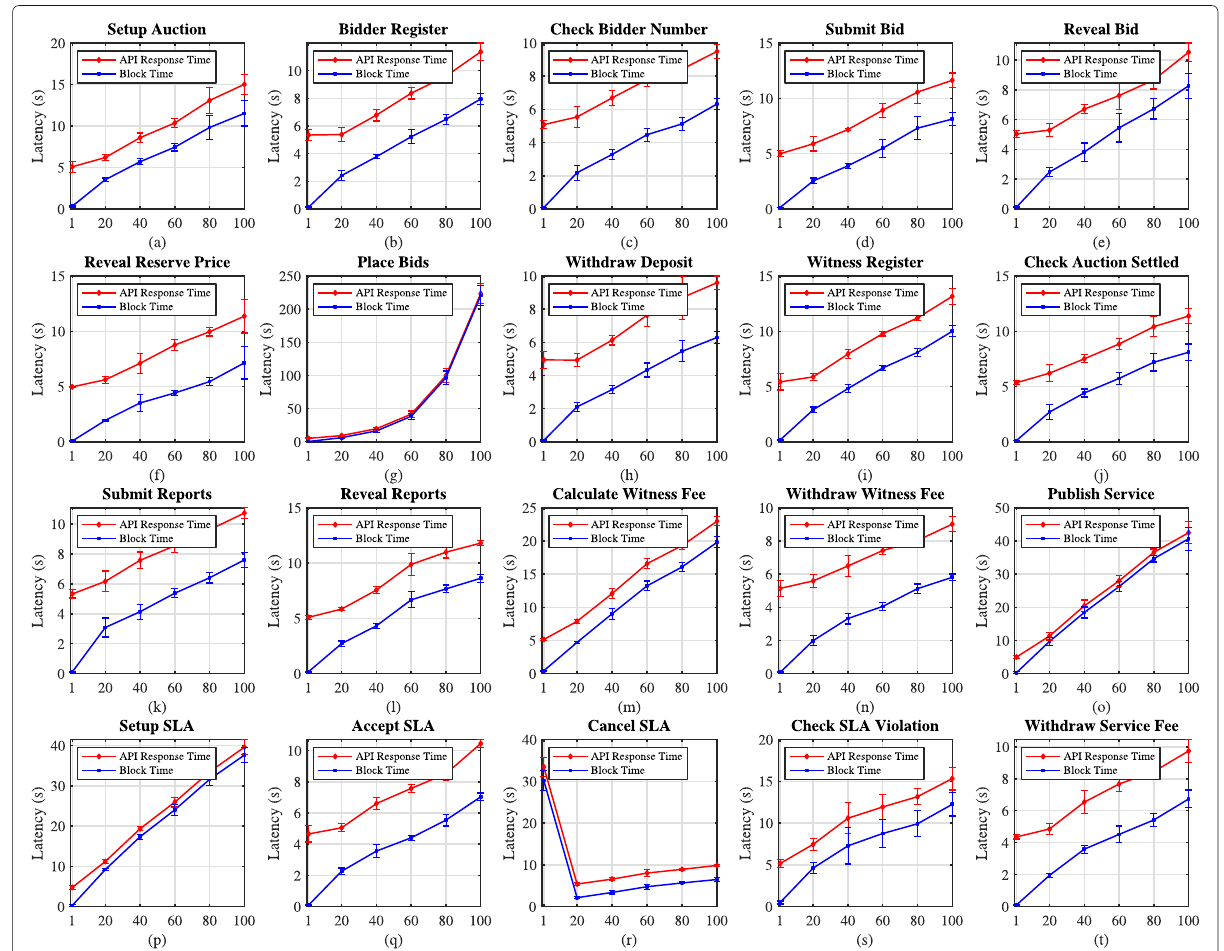
Fig. 12 Execution latency of different function interfaces in AWESOME smart contracts under the best mining